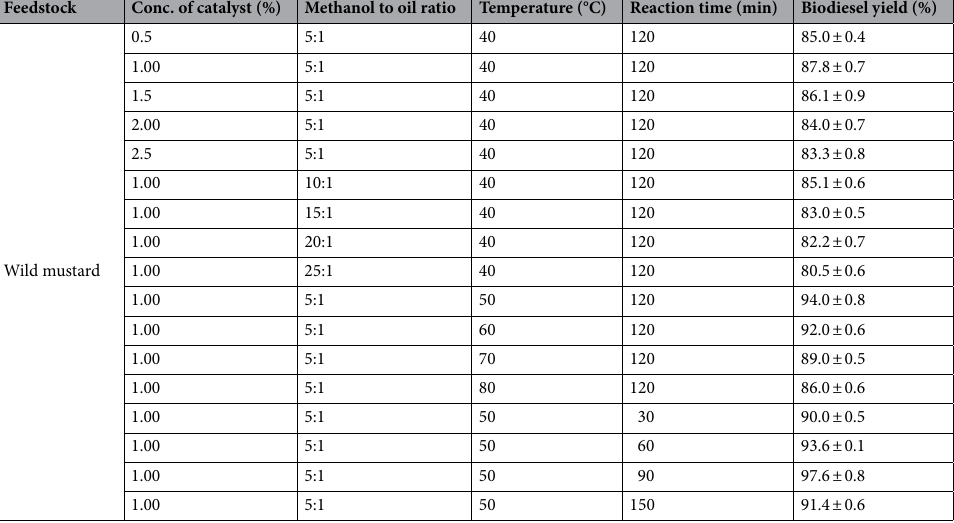
Table 4. Transesterification reaction parameters for wild mustard seed oil.